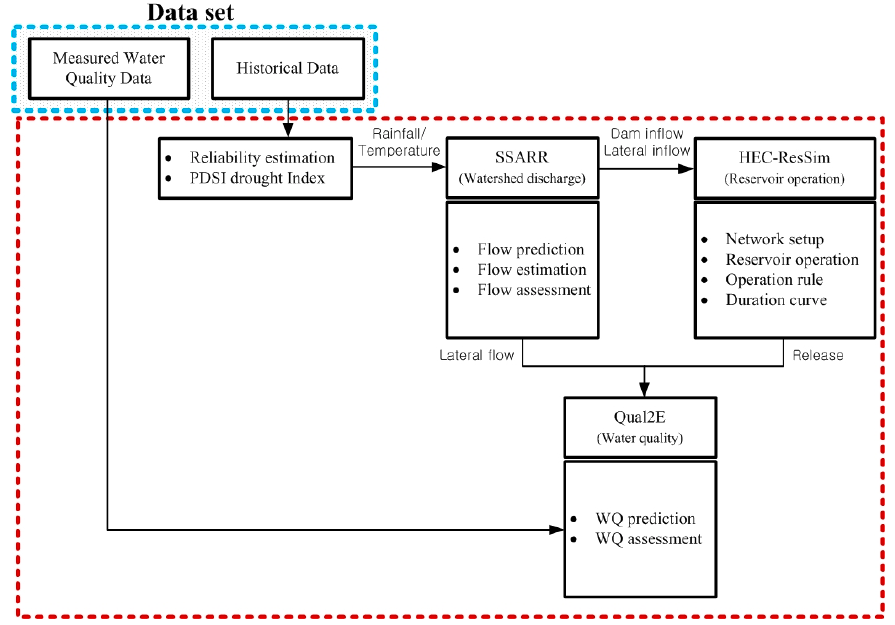
Figure 2. Assessment procedure of environmental effects for the operation of weirs and reservoirs.